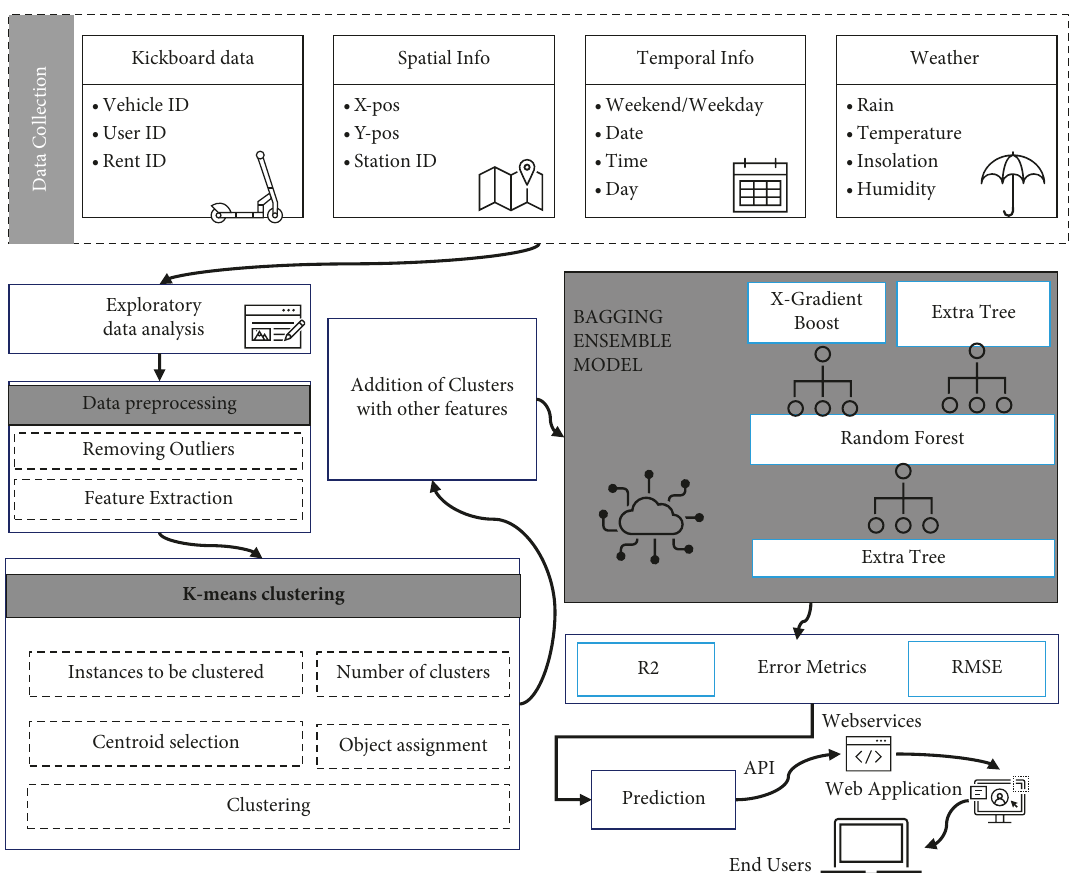
Figure 4: Structure of the proposed methodology.